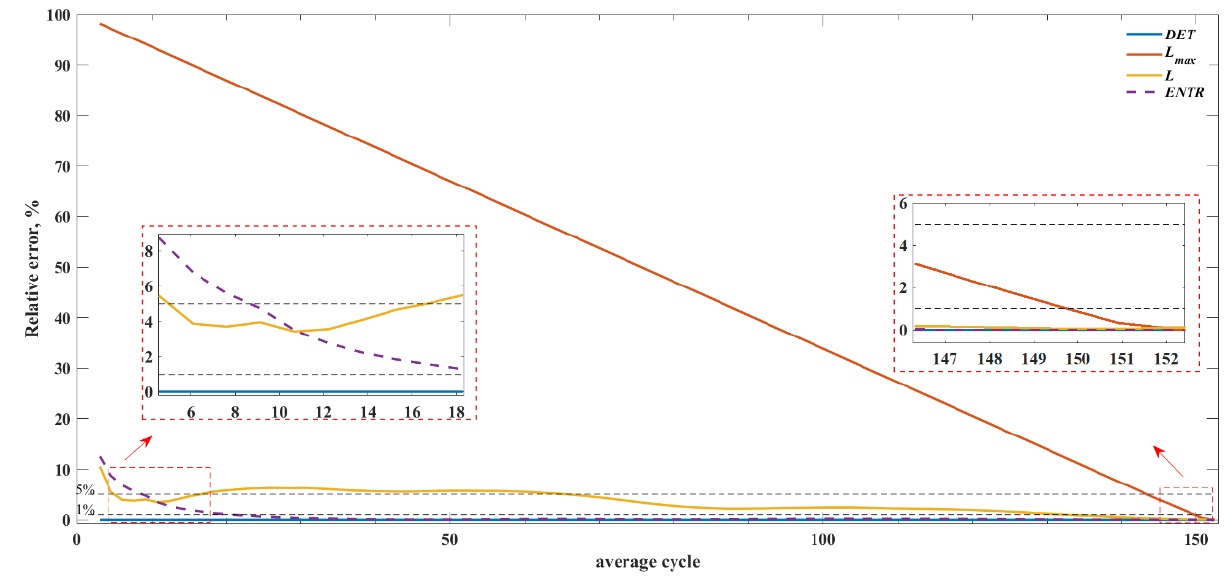
Figure 8. Relative error of the RQA features estimates as a function of the length of the time series. Table 3. Average values of the length of the time series corresponding to relative error below 5% and 1% and the reference RQA